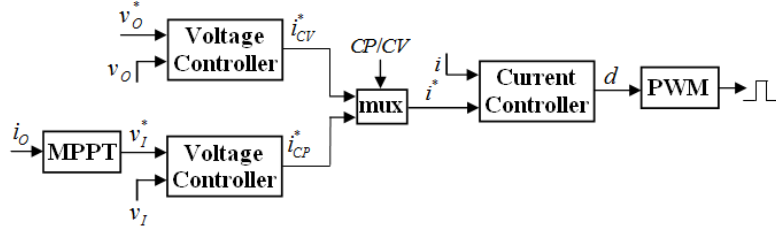
Figure 5. Single battery dual-mode control